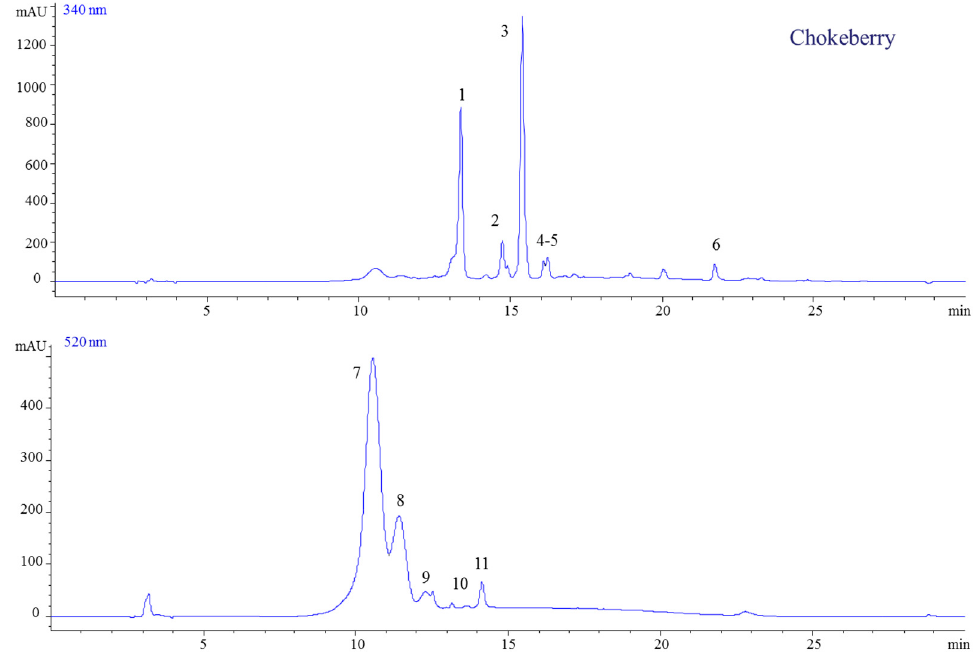
Figure 1. HPLC-DAD chromatogram of extracts from chokeberry jams (at 340 and 520 nm).